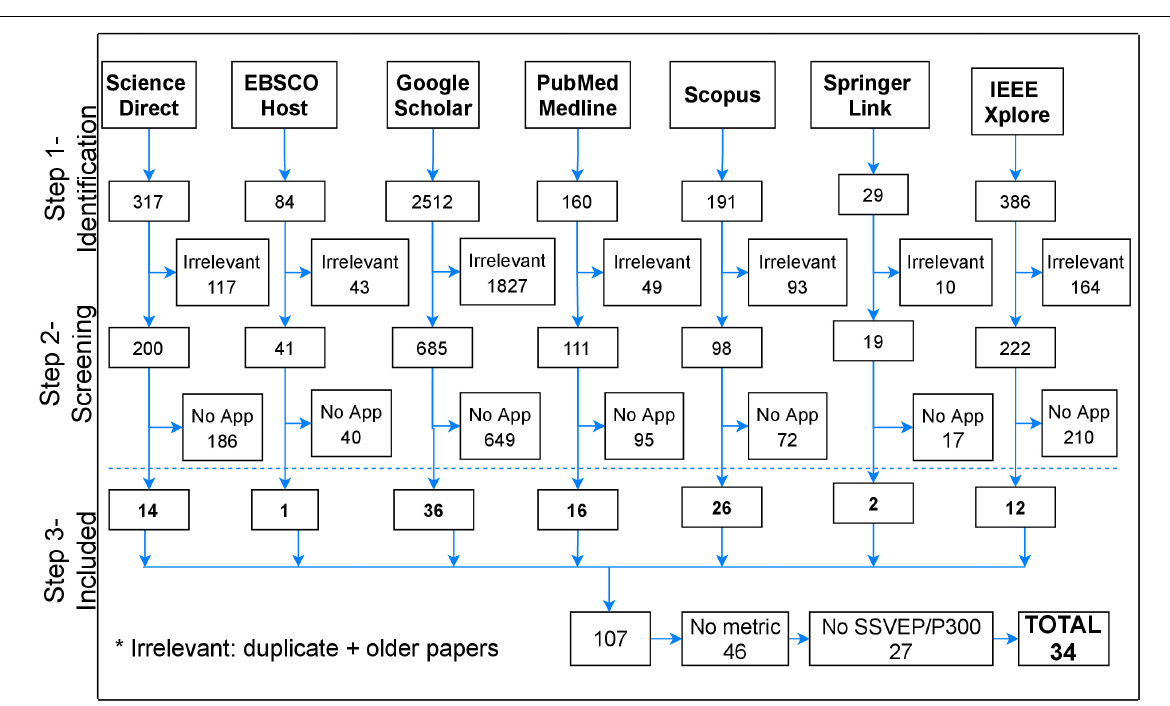
FIGURE 3 | Number of records identified from each database for the Systematic Literature